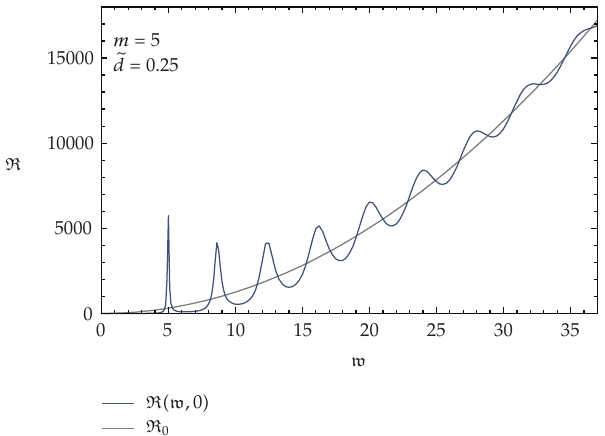
Figure 9: An example for a spectral function at finite baryon density, compared to the zero temperature